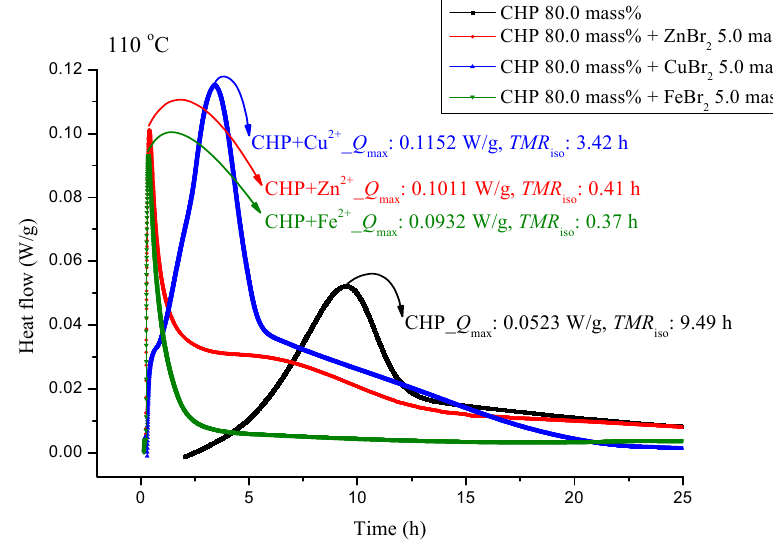
Figure 3. Heat flow versus temperature plot for 80.0 mass% CHP mixed with ZnBr 2 , CuBr 2 , or FeBr 2 , tested using TAM III scanning analysis at 110.0 °C.